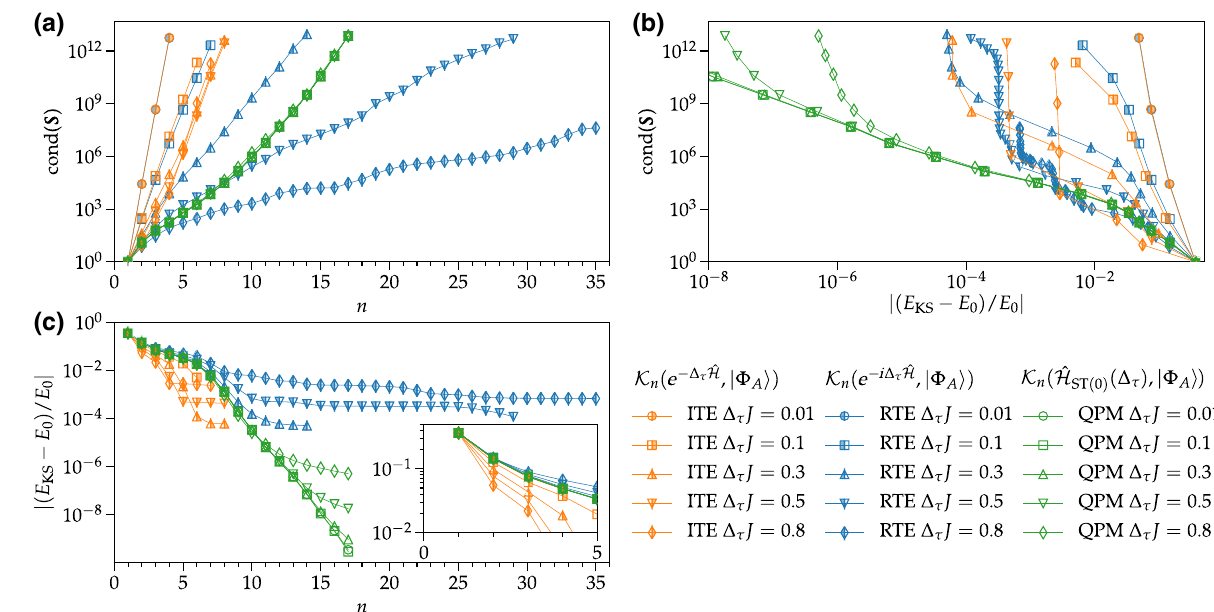
FIG. 10. Same as Fig. 8 but with the first-order Richardson extrapolation ( r = 1) for QPM.